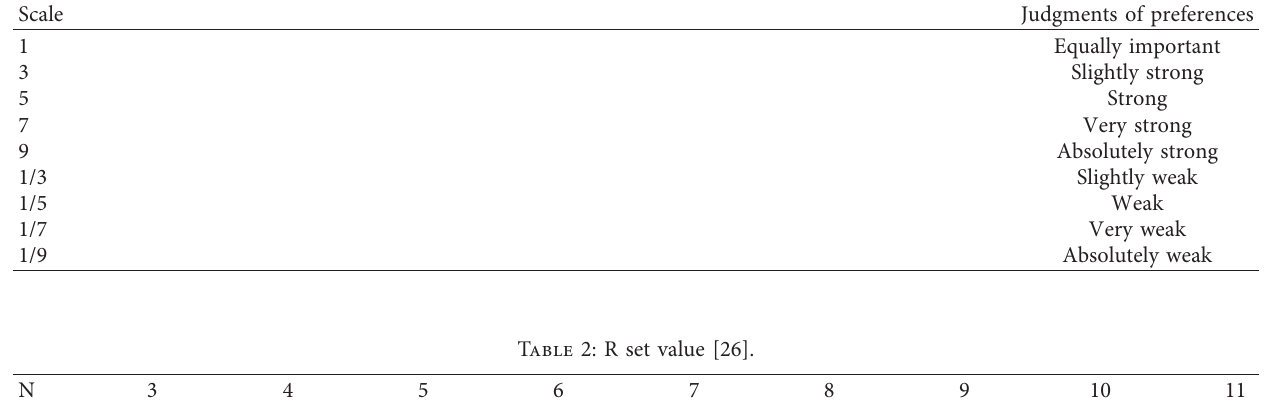
Table 1: Saaty’s nine-point intensity scale [24].